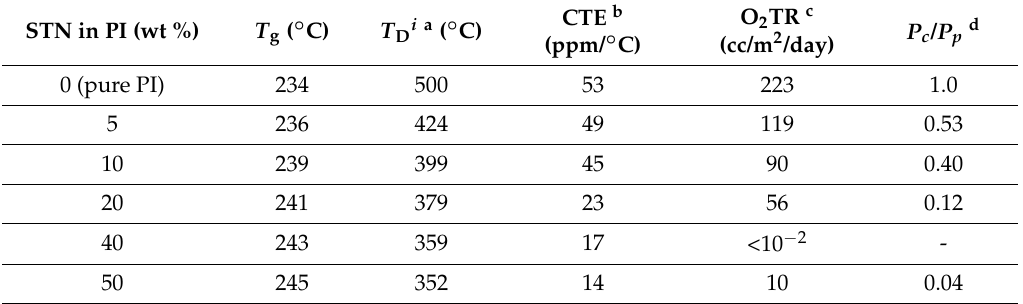
Table 5. General properties of the Co-PI hybrid films with varying STN